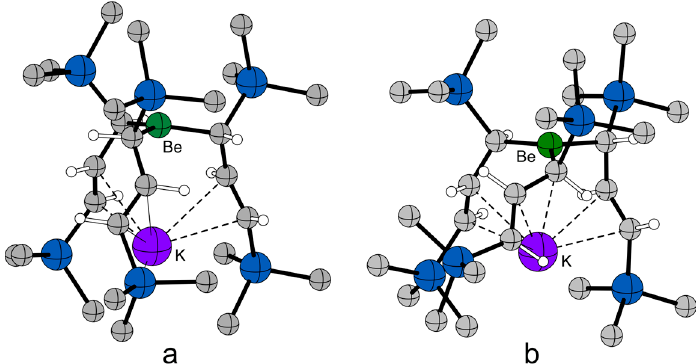
Figure 4. Geometry optimized structures of the K[BeA’ 3 ] complex: ( a ) as found in the crystal structure of 1 ; and ( b ) related S,S,R form.